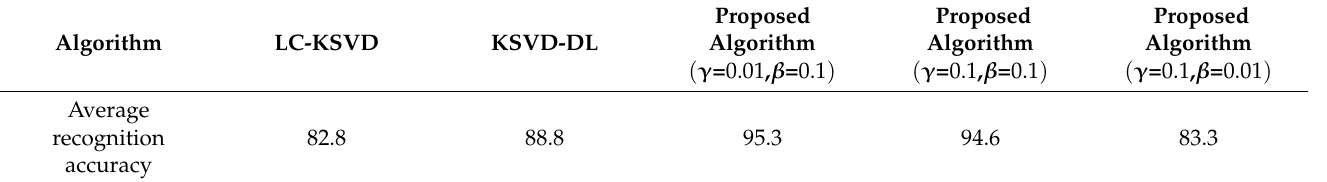
Figure 14. The training time of the traditional algorithm and improved algorithm. Table 3. The comparison of the improved method with other methods (sample dimension M = 24).